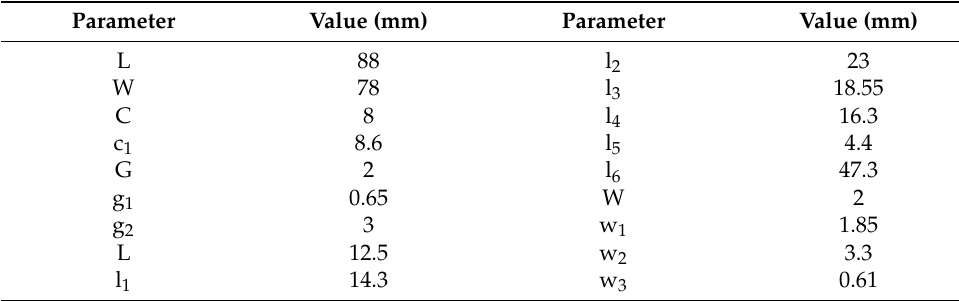
Figure 2. Proposed antenna: ( a ) top view: structure reserved for GPS and BLE (black color); ( b ) lumped components, UFL connector and PIN diode placements; ( c ) bottom view; ( d ) top view with geometric key parameters. Table 1. Key geometric parameters of the